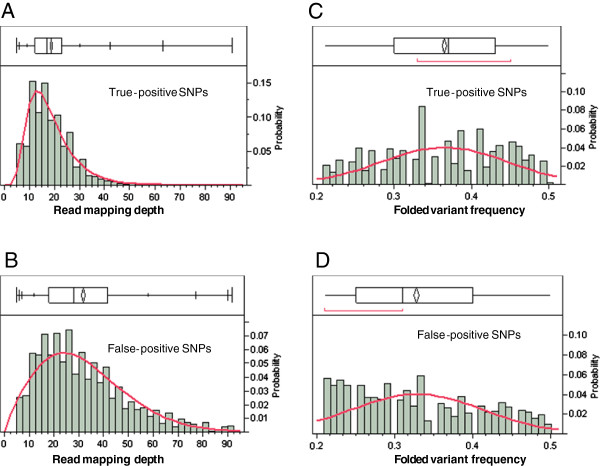
Frequency distribution (bottom of each figure) and quantile box (top of each figure) of SOLiD read mapping depths in walnut BESs (A and B) and SNP folded variant frequency (FVF) (C and D) for true-positive SNPs (A and C) and false positive SNPs (B and D). Frequencies and quantiles were computed from Infinium genotyping of 6,000 SNP markers and corresponding data of read mapping depth and FVF in SNP discovery.